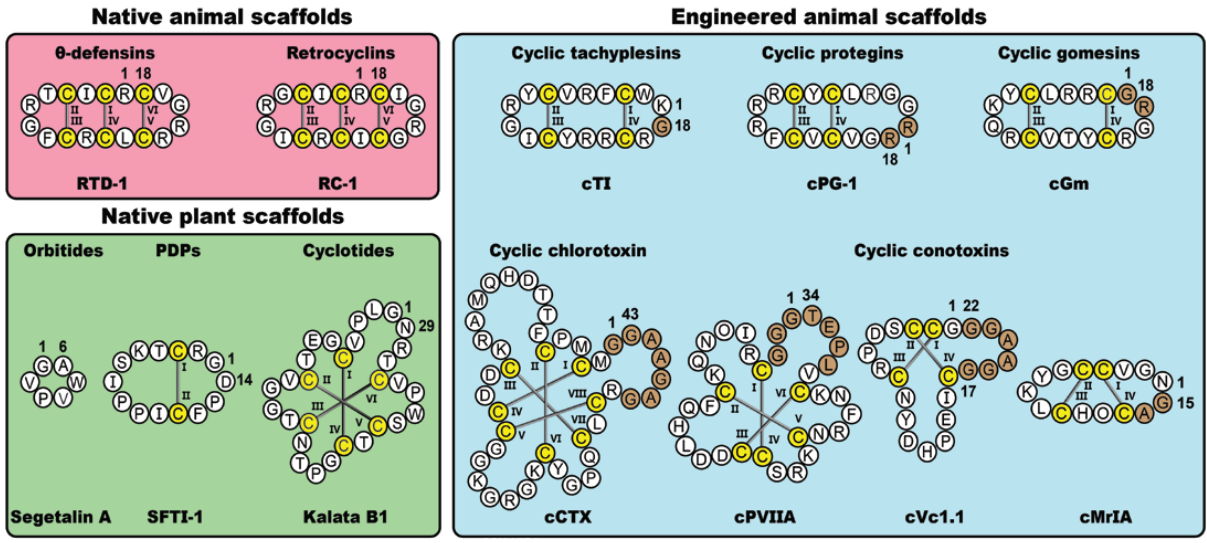
Figure 1. Selected classes of native and engineered cyclic disulfide-rich peptides derived from plants and animals, with representative examples from each class. Cysteine residues are numbered and highlighted in yellow, with engineered cyclization linkers represented by brown shading.